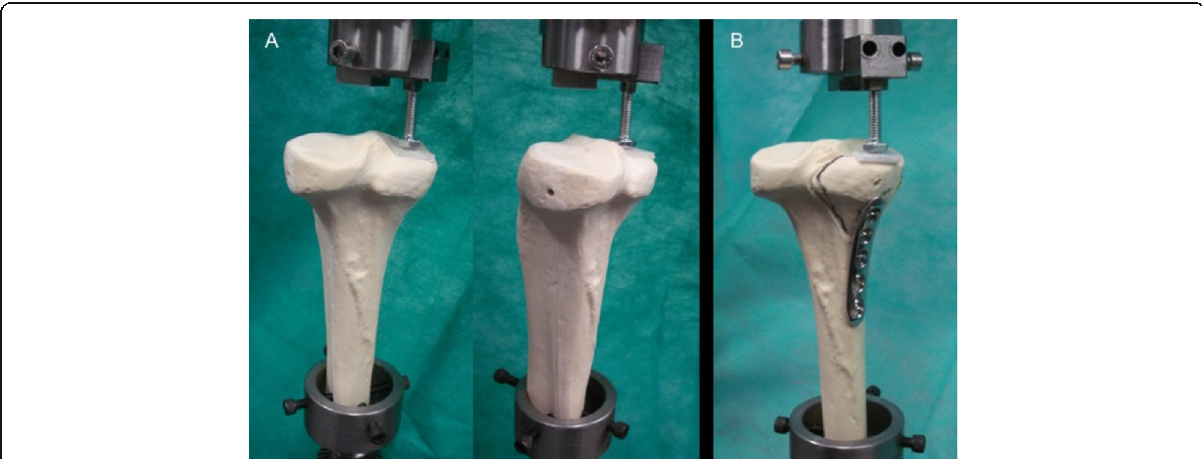
Fig. 3 a The specimens were positioned vertically onto a test jig with a polypropylene plate measuring 20 × 15 × 3 mm clamped on the upper side of the material testing machine to deliver forces at the point of loading on the posteromedial tibial plateau. b LCP specimen